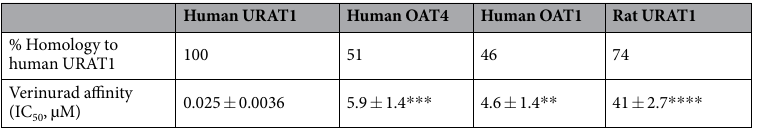
Human URAT1 Human OAT4